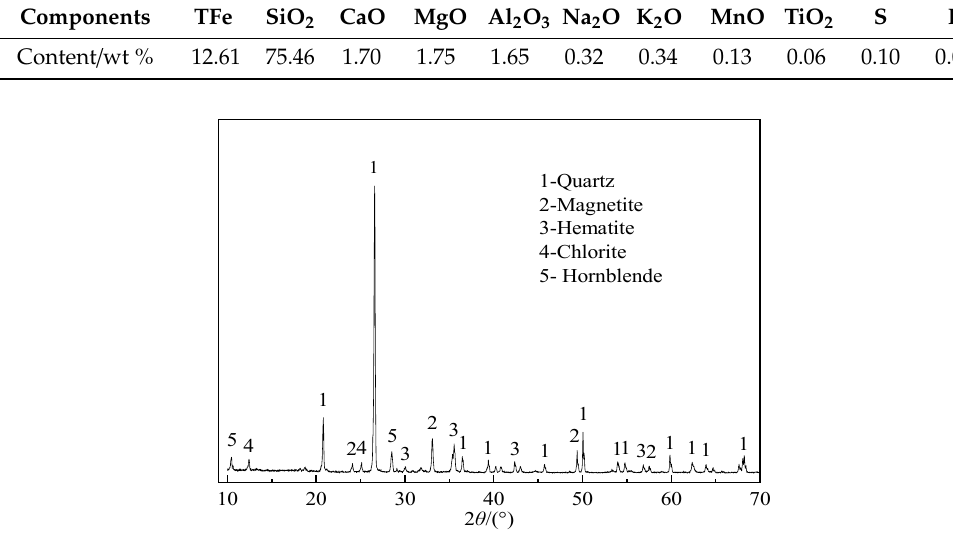
Figure 1. XRD pattern of the IOTs. Table 2. Analysis of the iron phases in the IOTs.